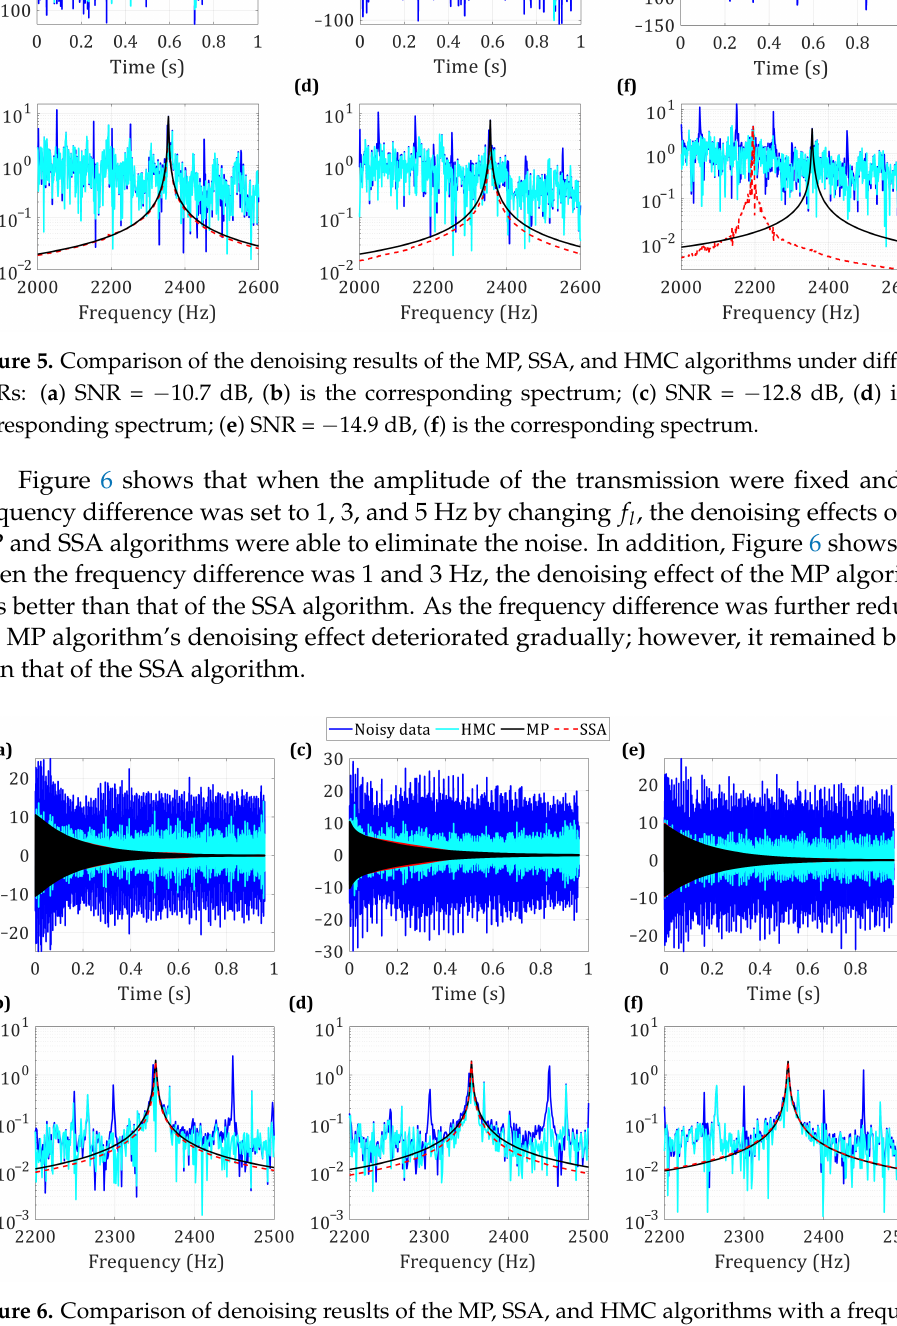
Figure 6. Comparison of denoising reuslts of the MP, SSA, and HMC algorithms with a frequency difference of 1, 3, and 5 Hz: ( a ) ∆ f = 1 Hz, ( b ) is the corresponding spectrum; ( c ) ∆ f = 3 Hz, ( d ) is the corresponding spectrum; ( e ) ∆ f = 5 Hz, ( f ) is the corresponding